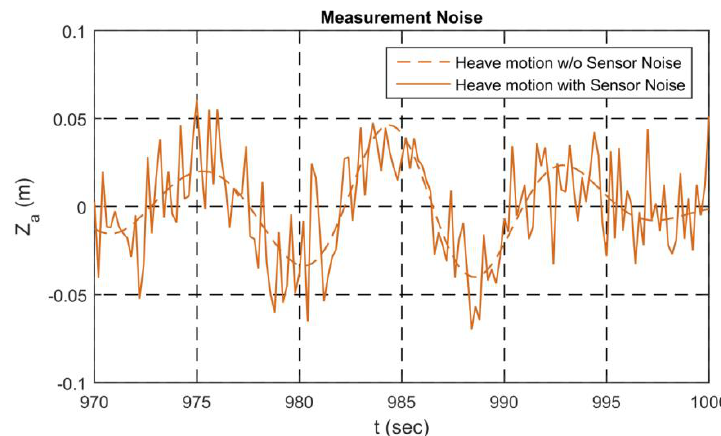
Figure 6. Time series of heave motion with sensor noise.